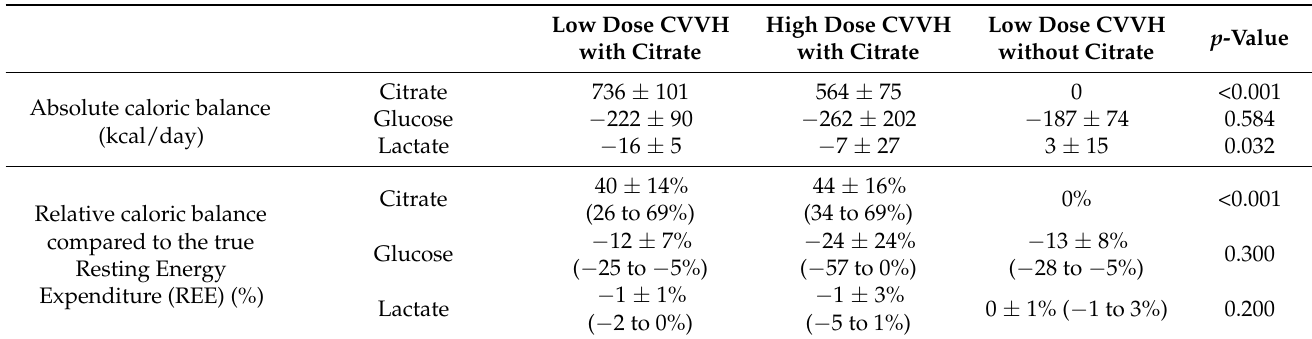
Values are expressed in mean ± standard deviation. In the relative caloric balance, the minimum and maximum were also added between ( ).